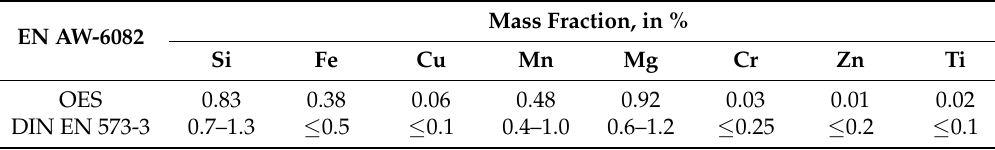
Mass Fraction, in